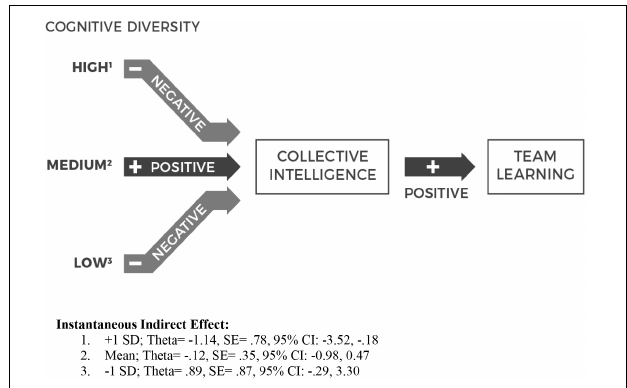
FIGURE 3 | The relationship between cognitive style diversity, collective intelligence and team